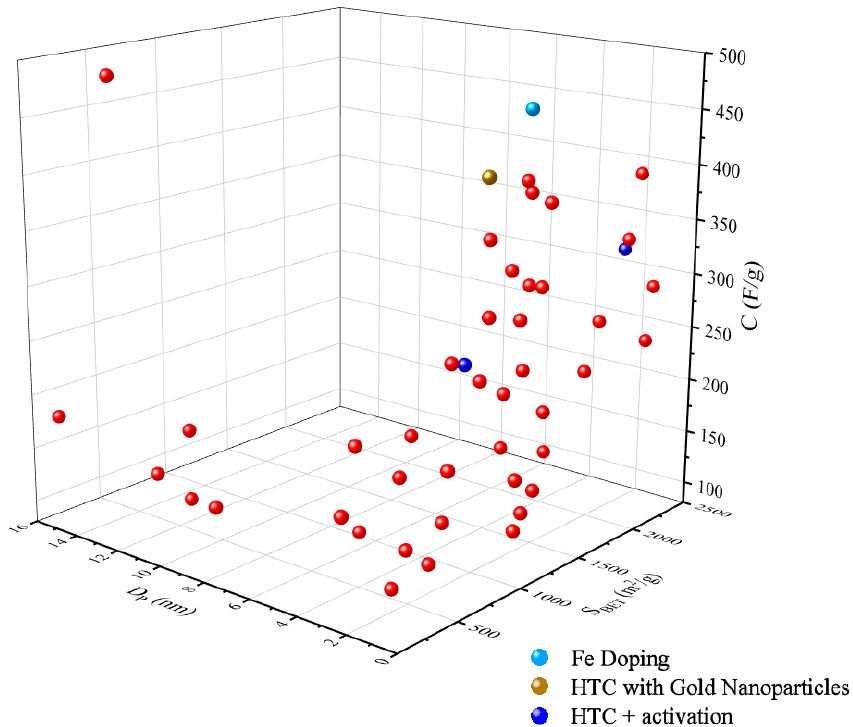
Figure 5. Distribution of the specific capacitance, C (F/g), of hydrochar for supercapacitor applica- tion with correlation to the pore size, D p (nm), and BET-specific surface area, S BET (m 2 /g) .